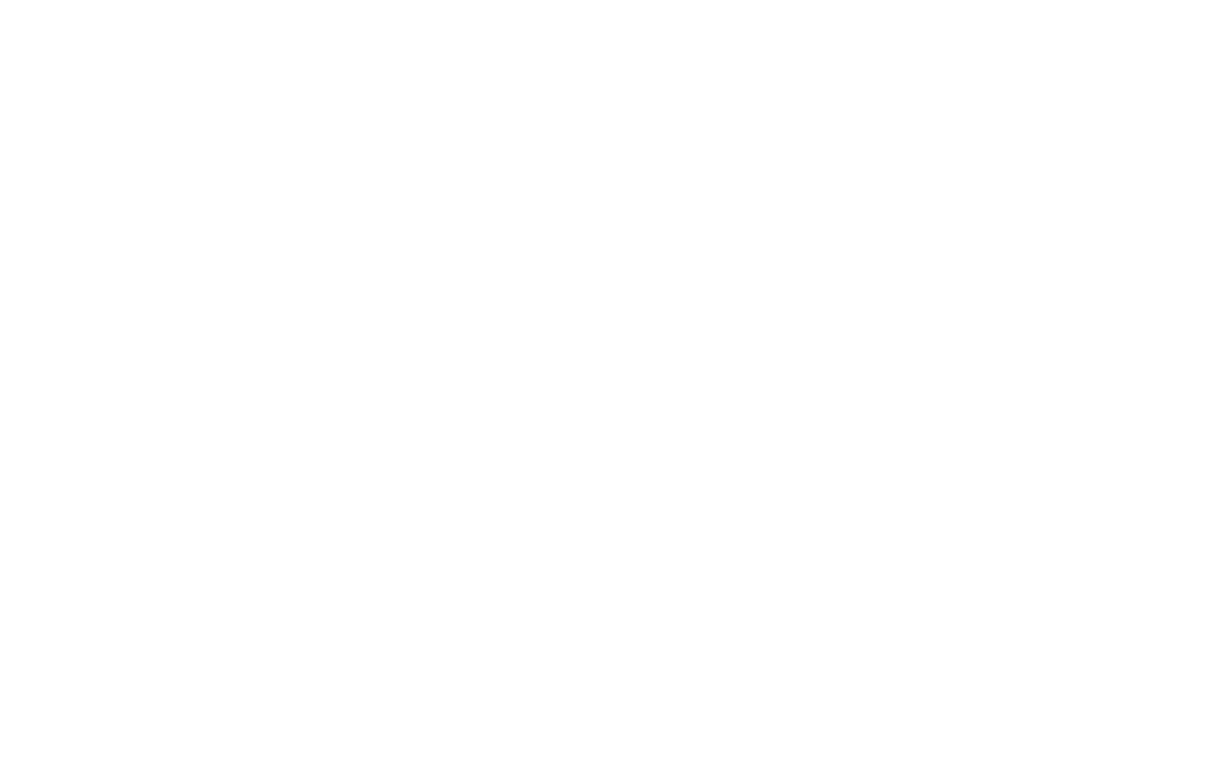
PLOS ONE | https://doi.org/10.1371/journal.pone.0211255 January 17,